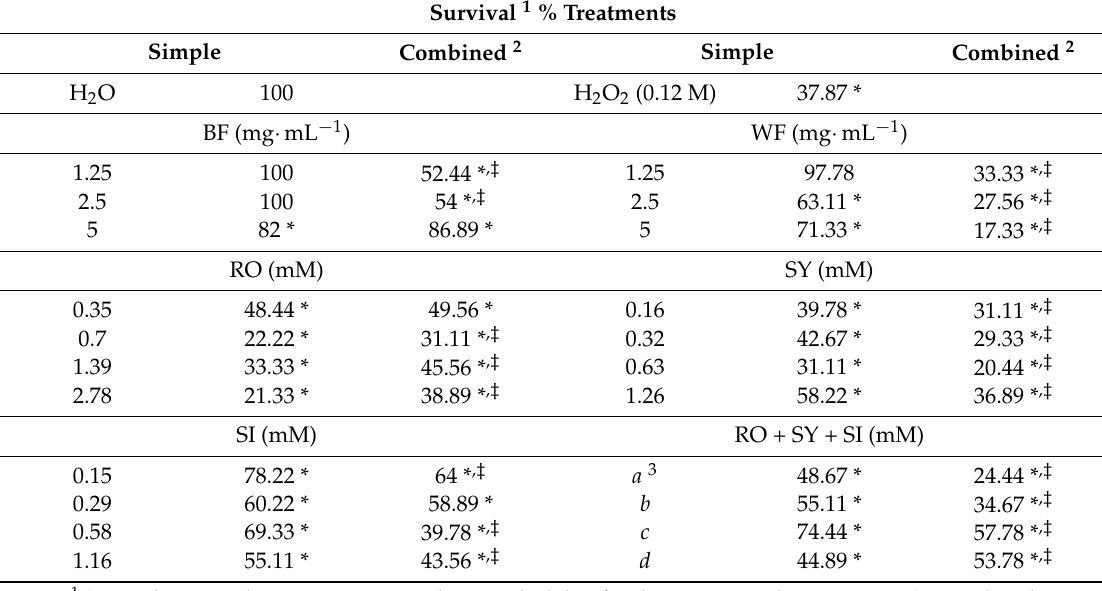
Table 1. Toxicity of Borago officinalis plant material, blue flowered (BF) and white flowered (WF), and the bioactive compounds, rosmarinic (RO), syringic (SY) and sinapic (SI) acids.